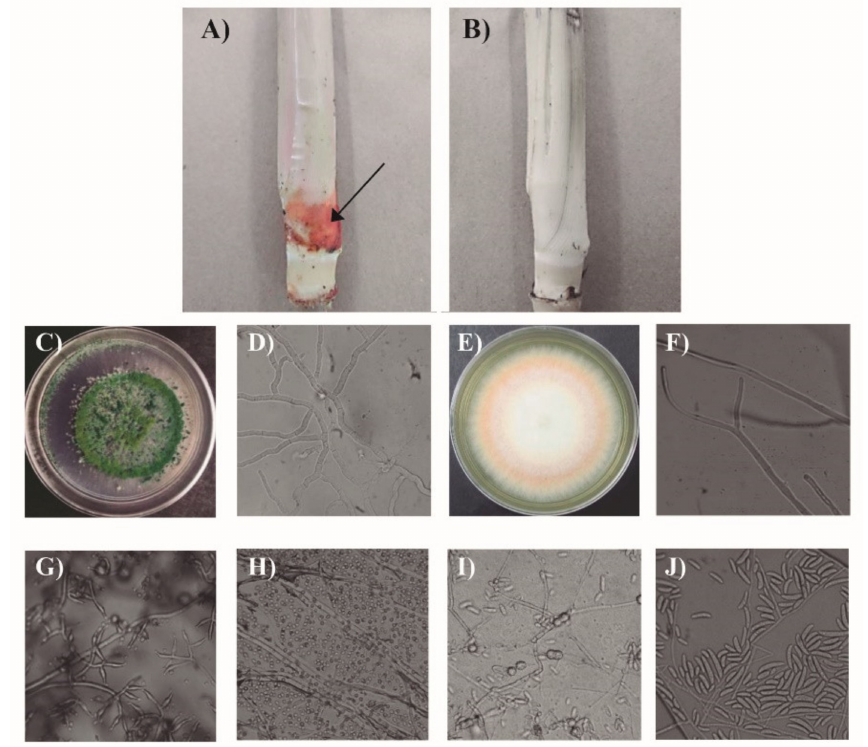
Figure 5. Base of the sugarcane culm exposed to the tested treatments and isolates of Trichoderma sp. and a Fusarium species complex from the roots of sugarcane plants to test the Koch’s postulates. ( A ) Presence of a red ring at the base of the culm in plants inoculated with Fusarium sp. on the root without fungicidal agents; ( B ) absence of red ring at the base of the culm in plants inoculated with Fusarium sp. on the root with any of the combinations of fungicidal agents ( Trichoderma + Phi); ( C ) Trichoderma sp. colony in PDA; ( D ) Trichoderma sp. septate mycelium.; ( E ) Fusarium sp. colony in PDA; ( F ) Fusarium mycelium; ( G ) phialides in Trichoderma isolate; ( H ) Trichoderma spores; ( I )